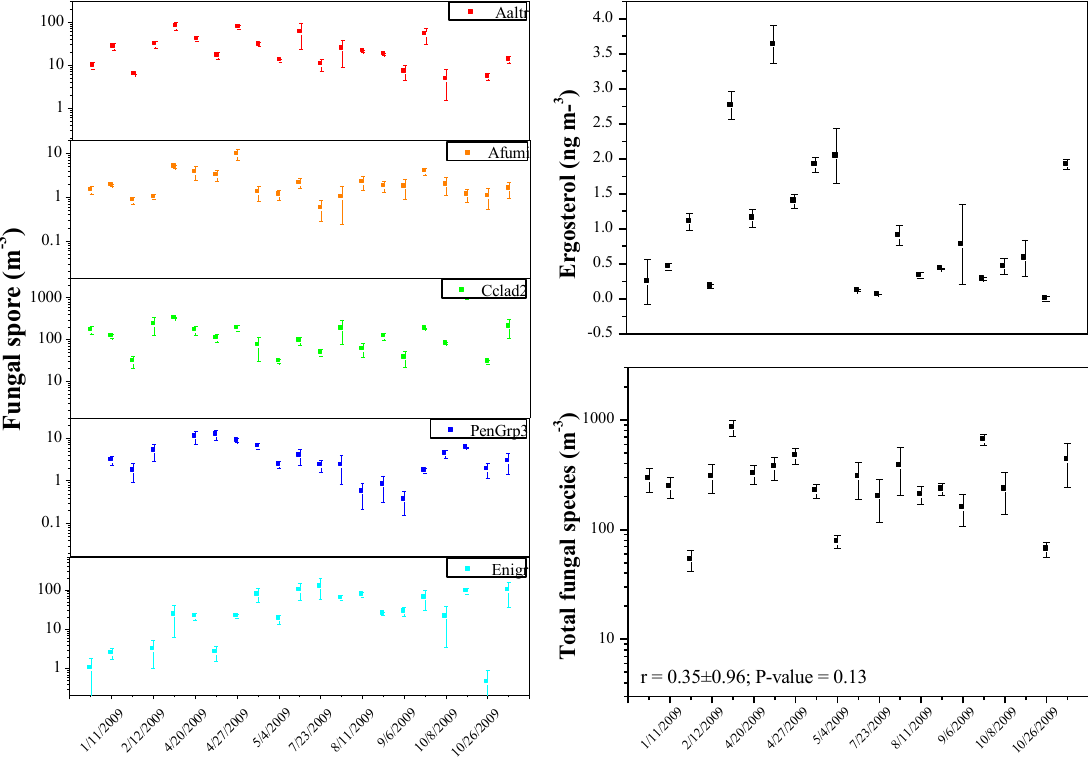
Figure 4. 506 Fig. 4. Seasonal ergosterol concentrations (top right graph) (Burshtein et al., 2011), compared to the sum of specific fungal spore concen- trations (bottom right graph) from PM 10 filters, with a correlation coefficient specified in the lower graph. The specific fungal species are specified on the left graphs ( Alternaria alternata , Aaltr; Aspergillus fumigatus , Afumi; Cladosporium cladosporioides , Cclad2; Penicillum Chrysogenum , PenGrp3 Eppicocum nigrum , Enigr). The error bars are standard deviations, n=21 samples for ergosterol, and n = 25 samples for fungal spore. Table 3. Seasonal correlation coefficients between Ergosterol and spore